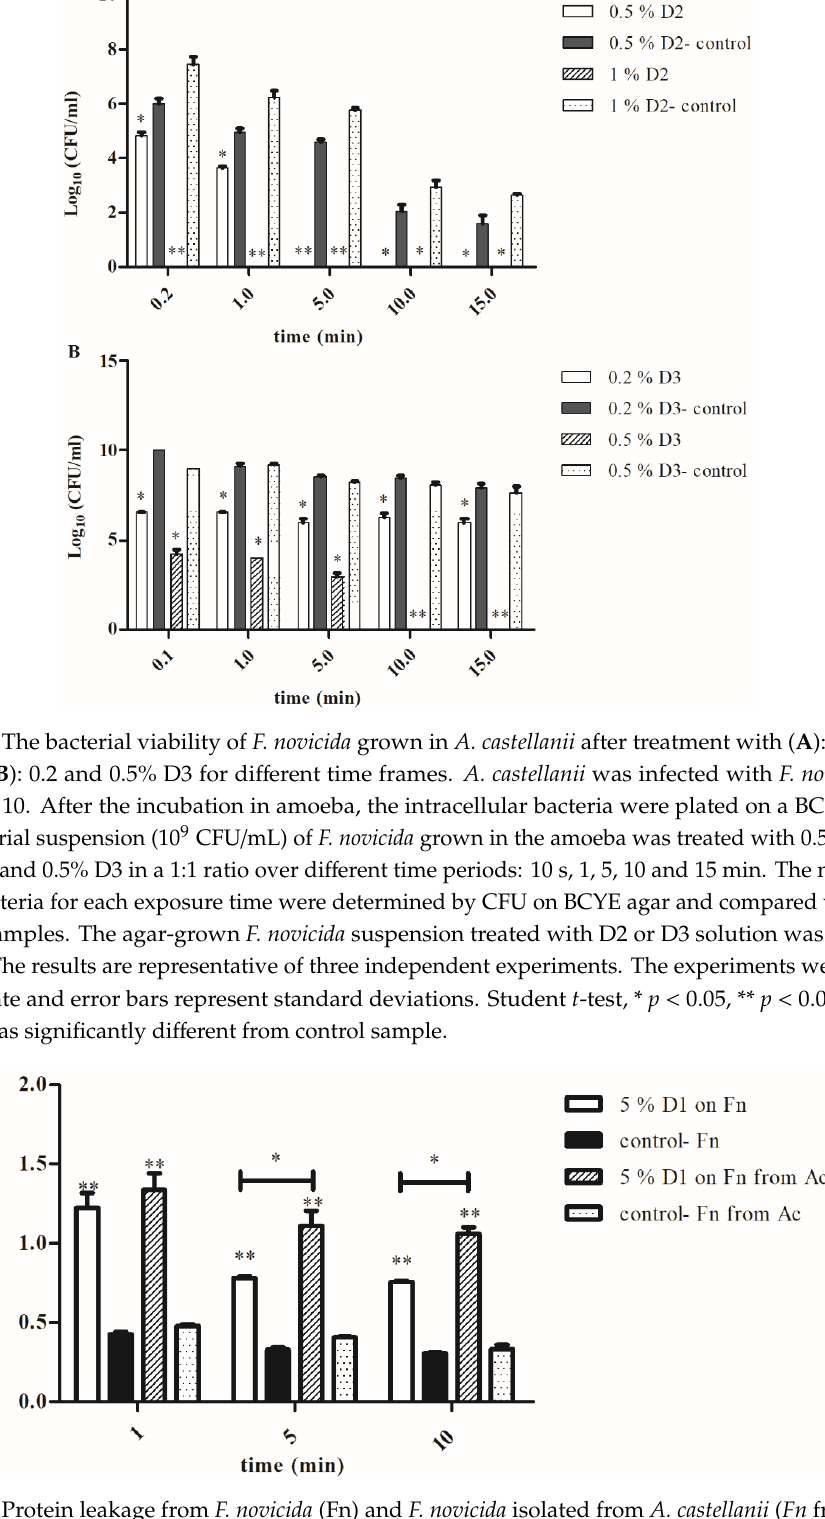
Figure 4. Protein leakage from F. novicida (Fn) and F. novicida isolated from A. castellanii ( Fn from Ac), treated with 5% D1. The bacteria were treated with 5% D1 for 1, 5 or 10 min. The cells were centrifuged at 2700 × g for 2 min and the proteins leaked in supernatants were measured as absorbance values at 280 nm. The supernatants of the untreated amoeba- or agar-grown bacteria were used as control. The experiments were done in triplicate and error bars represent standard deviations. Student t -test, * p < 0.05, ** p < 0.001 were accepted as significantly di ff erent from control